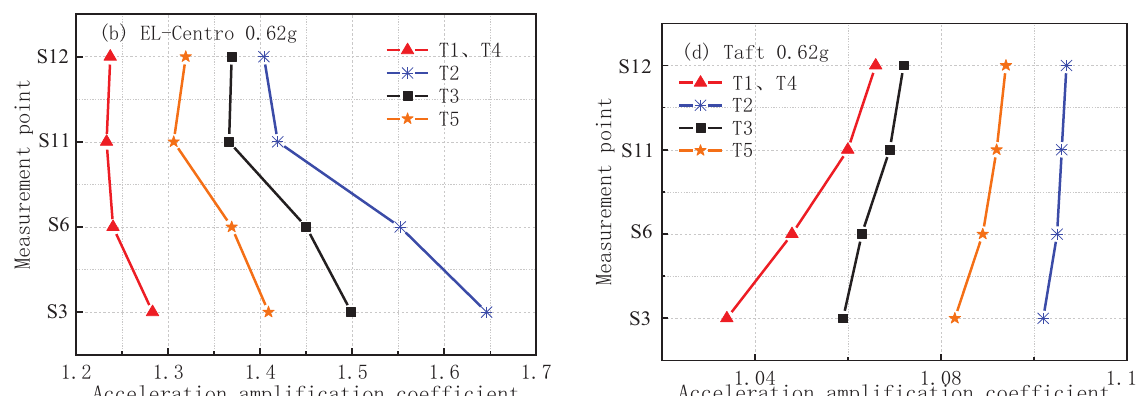
Fig. 4. Envelope curve of acceleration ampli fi cation coef fi cient with the seismic wave (0.22g; 0.4 g; 0.62